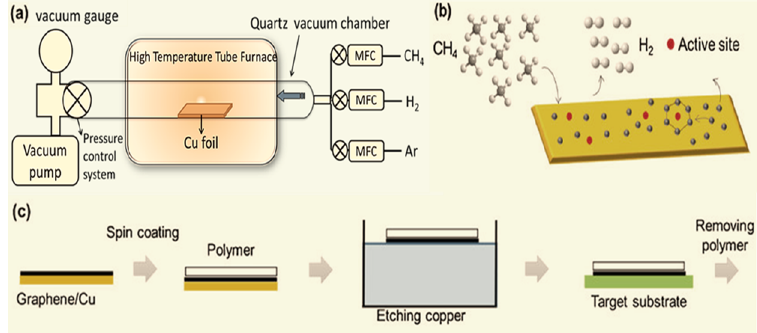
Figure 9. Graphene synthesis via chemical vapor deposition (CVD): ( a ) Chemical vapor deposition reactor. ( b ) Growth mechanism of graphene on the copper substrate via deposition. ( c ) Schematic illustration of the transfer process of the graphene sheet; spin coating with a polymethylmethacrylate (PMMA) polymer, etching copper with FeCl₃, graphene on a PMMA support is transferred onto the Si/SiO₂ target substrate, and PMMA is removed by acetone.